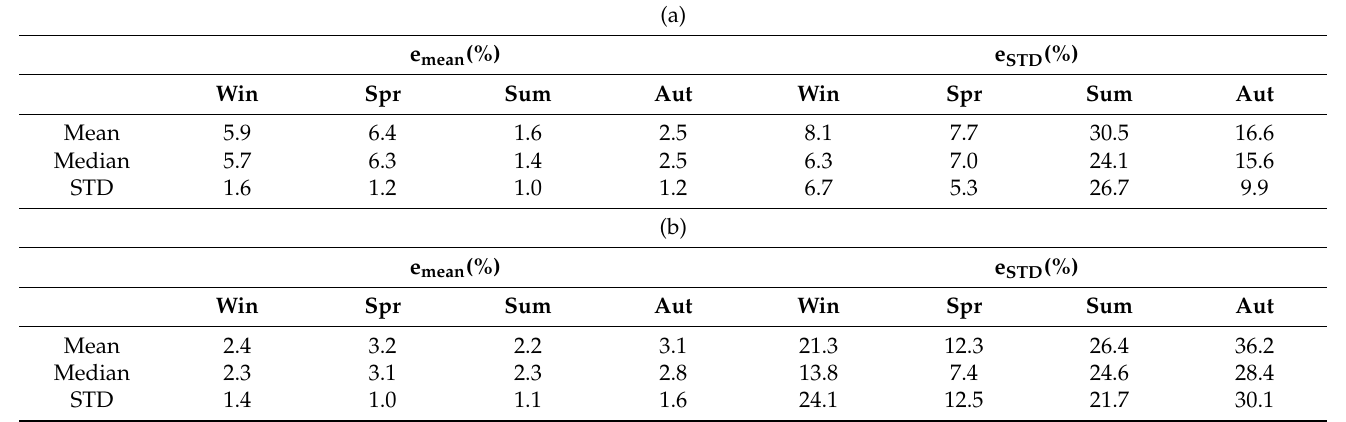
Table 6. (a) Mean, median, and standard deviation (STD) of the errors on the mean (e mean ) and standard deviation (e STD ) evaluated in the case of synthetic soil moisture daily profiles, for the Patern ò case study, using twenty years of data for each individual season. (b) Mean, median, and standard deviation (STD) of the errors on the mean (e mean ) and standard deviation (e STD ) evaluated in the case of synthetic soil moisture daily profiles, for the Busachi case study, using twenty years of data for each individual